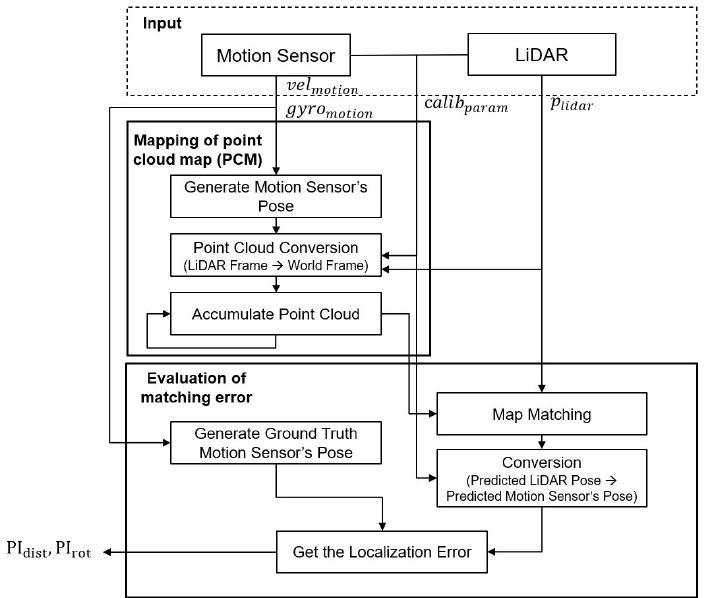
Figure 1. Algorithm of obtaining the proposed performance index of the calibration